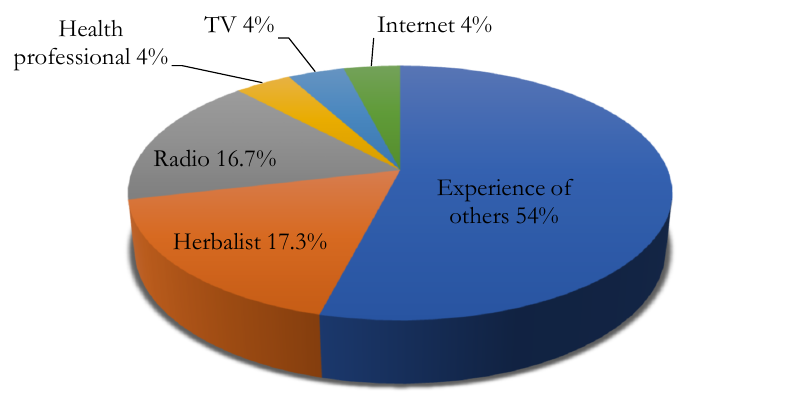
Figure 3. The percentage of information